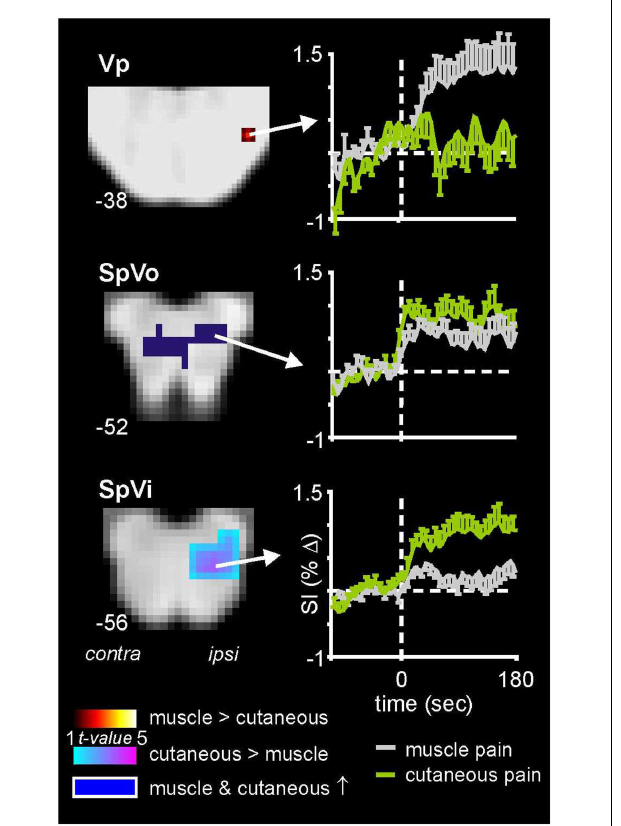
FIGURE 3 | Brainstem activation during noxious stimulation of the masseter muscle and the skin overlying the masseter muscle in 18 healthy subjects . Note that whereas cutaneous and muscle pain evoked activation of both the caudalis (data not shown) and oralis divisions of the spinal trigeminal nucleus (SpVo), only cutaneous pain activated the interpolaris division of SpV (SpVi). Furthermore, only muscle pain activated the principle trigeminal nucleus (Vp).The slice locations in Montreal Neurological Institute space are shown at the lower left of each section. Plots of mean ( ± SEM) percentage change in signal intensity (SI) over time are shown for each region.The vertical dashed lines indicate the onset of either the cutaneous (green) or intramuscular (gray) injections of hypertonic